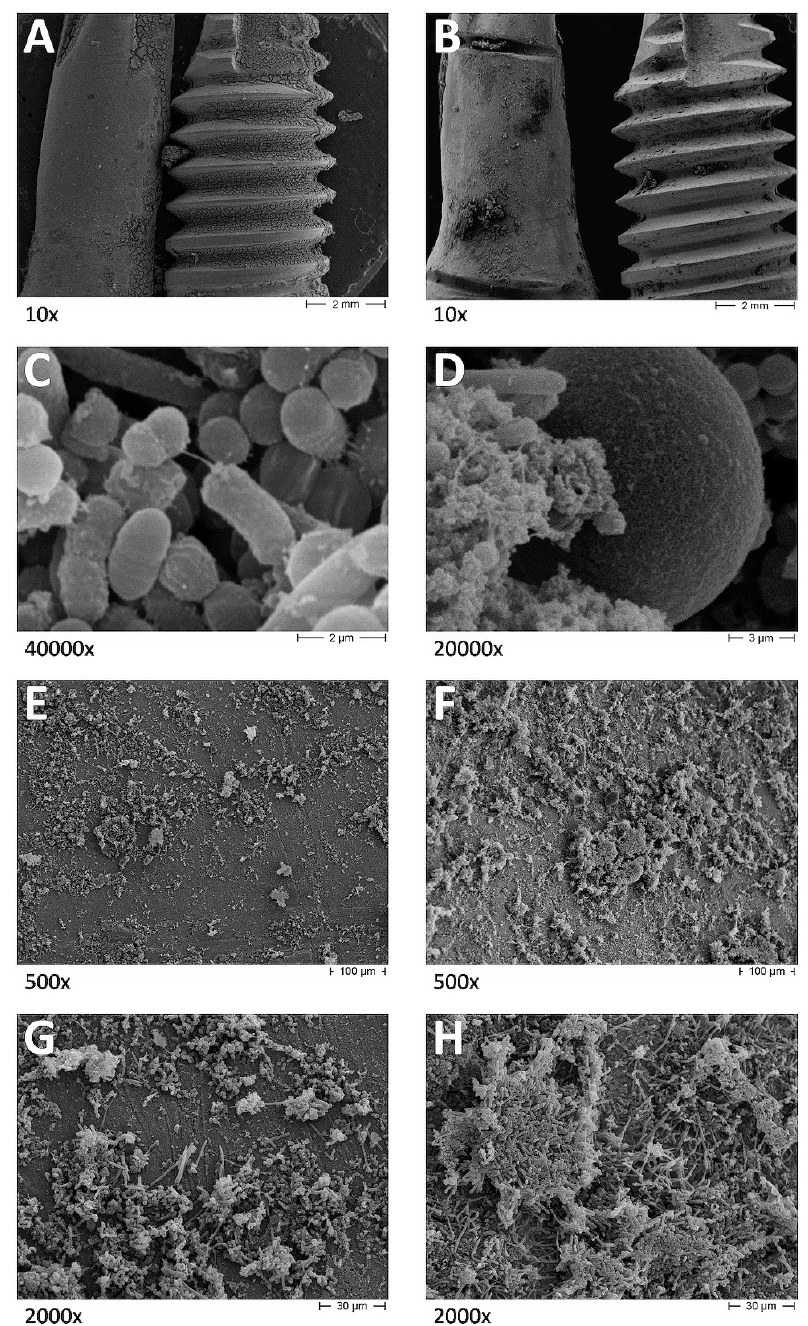
Figure 3. SEM micrographs of control specimens. ( A ) test and control specimens exposed to oral environment at 10 × magnification; ( B ) test and control specimens covered by VPS layer at 10 × magnification; ( C ) control specimen exposed to the oral environment at 40,000 × magnification; ( D ) control specimen covered by VPS layer at 40,000 × magnification; ( E ) Test specimen covered by VPS layer at 500 × magnification; ( F ) control specimen covered by VPS at 500 × magnification; ( G ) test specimen covered by VPS layer at 2000 × magnification; ( H ) control specimen covered by VPS at 2000 ×